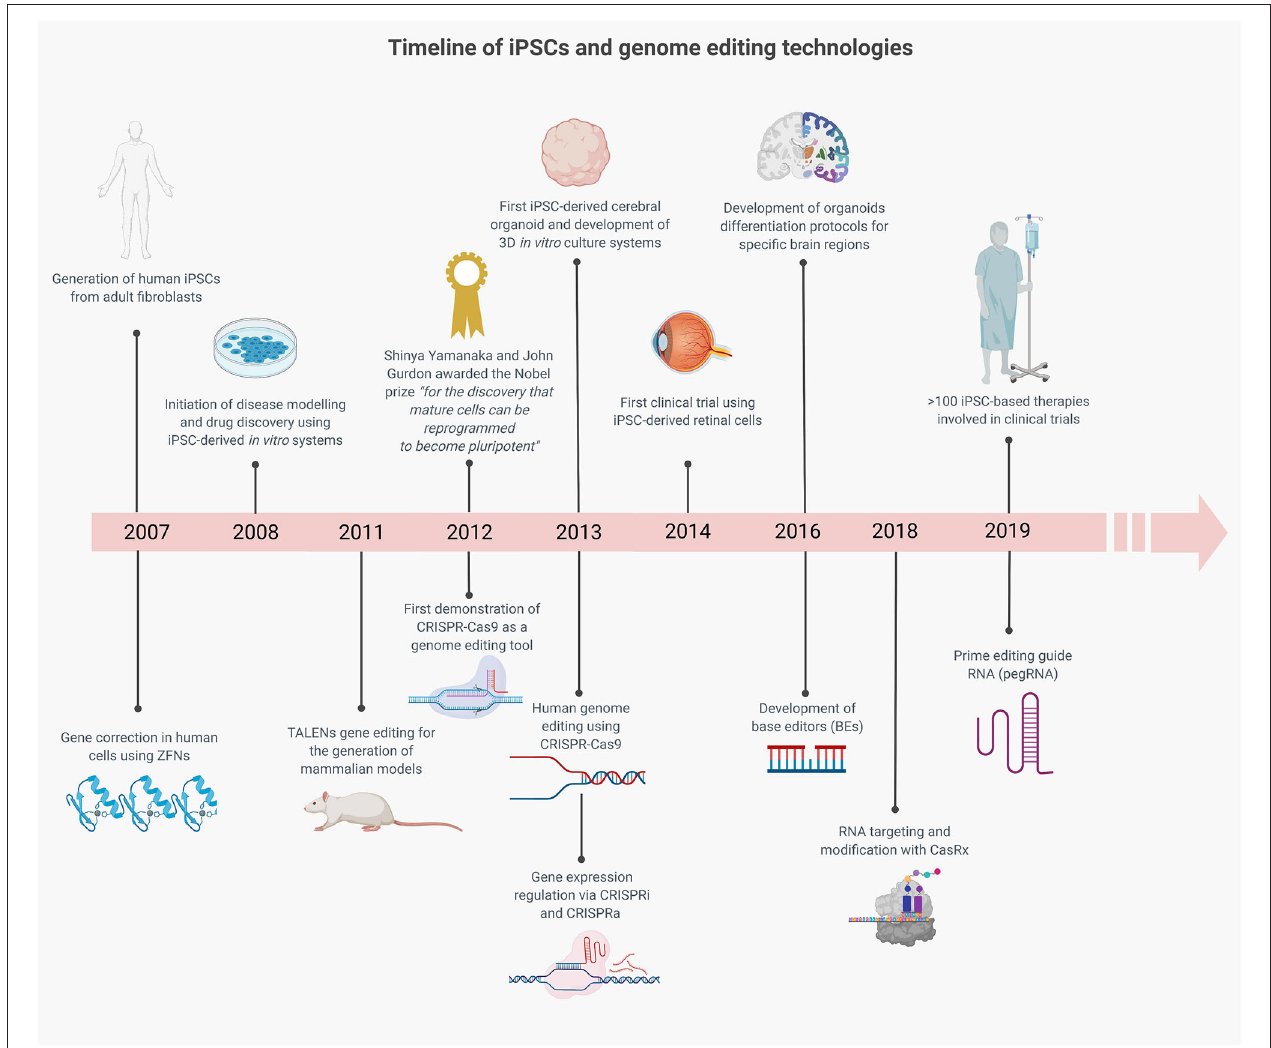
FIGURE 2 | Timeline showing the parallel development of iPSC and gene editing technologies which have advanced in vitro modeling of neurological diseases. The combination of these technologies has the potential to advance our understanding of disease mechanisms and to accelerate the translation of gene editing therapies into the